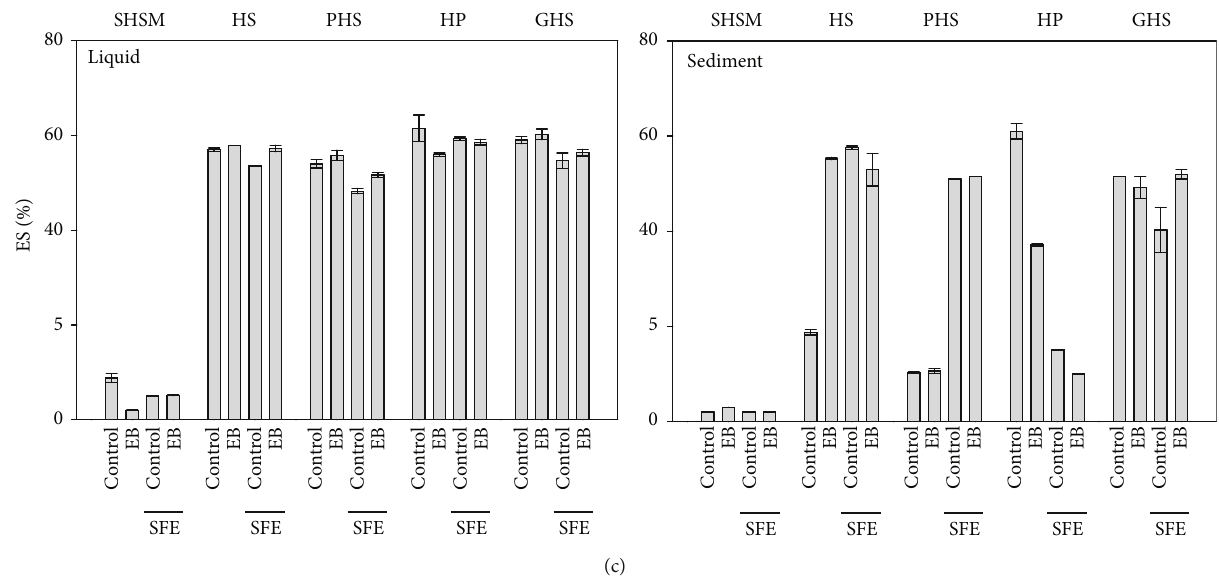
Figure 4: Emulsion properties of raw materials before and after oil removal and enzyme treatment. (a) Emulsion capacity (EC), (b) emulsion activity (EA), and (c) emulsion stability (ES) were measured from hempseed meal after oil recovery (SHSM), hempseed (HS), peeled hempseeds (PHS), hempseed protein (HP), and germinated hempseeds (GHS) before and after an enzyme blend for alcohol CGE (EB) hydrolysis and oil removal (SFE). Measurements were taken from liquid and sediment fractions of the